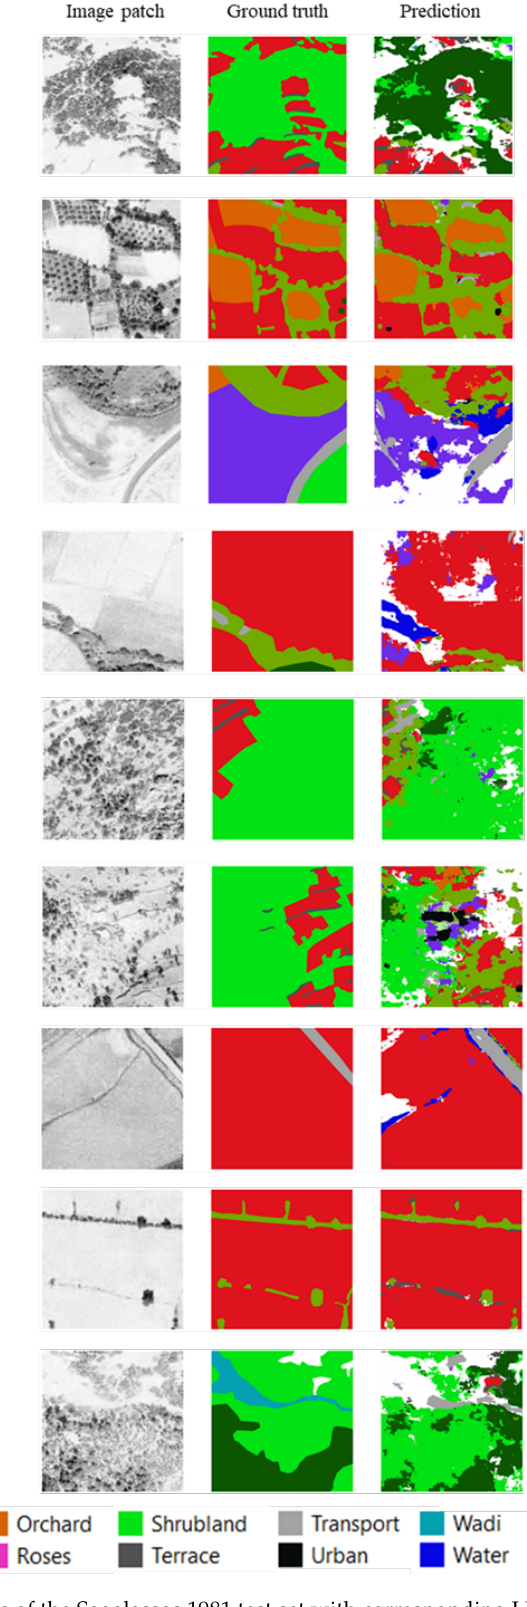
Figure 13. Example image patches of the Sagalassos 1981 test set with corresponding LULC ground truth and